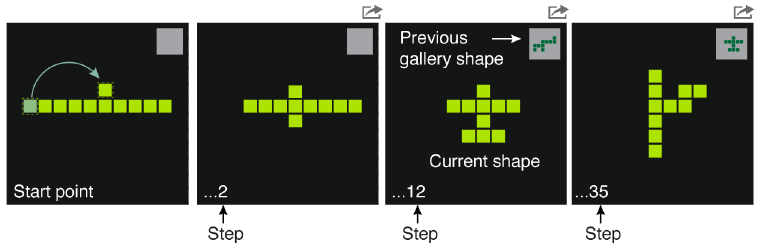
Fig 1. The creative foraging game allows high-resolution automated analysis of exploration and discovery processes. Players move squaresstarting from a 10-squareline with the aim of finding ‘interesting and beautiful’shapes. Moves keep all squares connected (not by a diagonal).A shape can be saved to a gallery by pressing the gray square at the top-right corner of the screen; in this square, the last shapechosen to the gallery is displayed(see Section B in S1